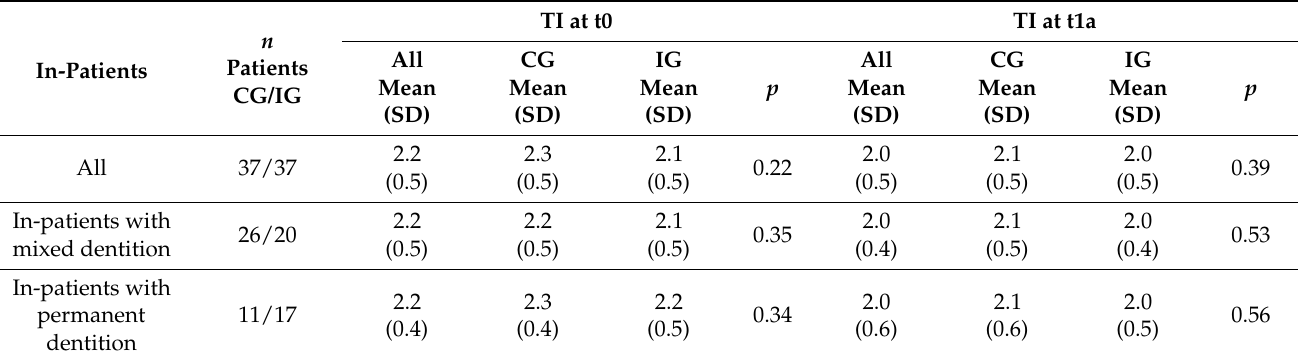
Table 3. Dental plaque in child and adolescent psychiatric in-patients (IG vs. CG) at the beginning (t0) and the end of hospitalization (t1a) with mixed and permanent